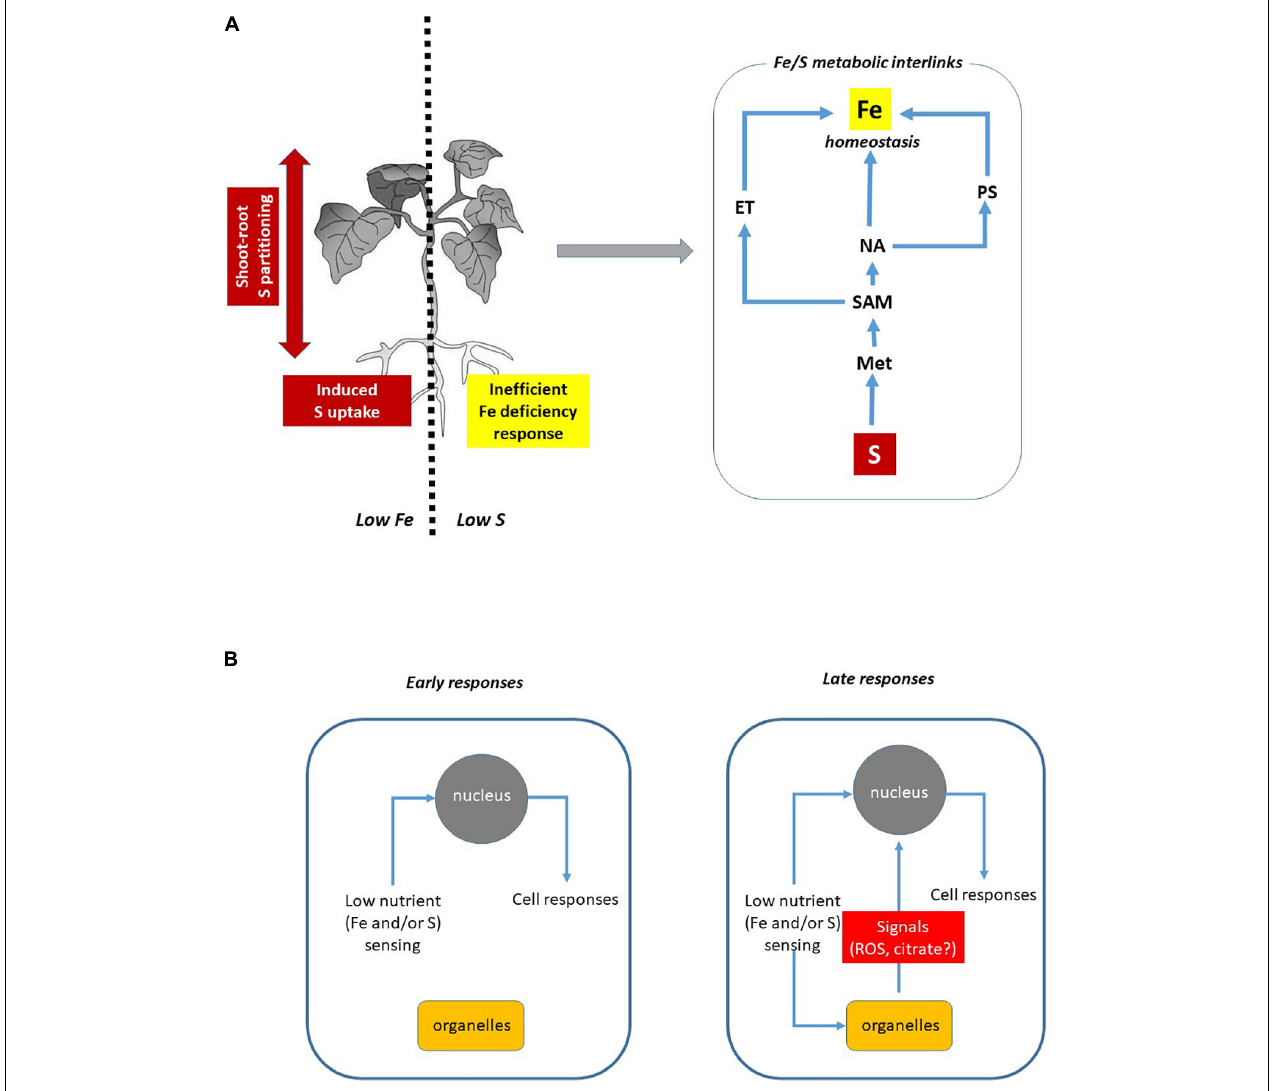
FIGURE 1 | Overview of Fe and S Interaction in plants. (A) In plants, Fe and S availability affect S and Fe homeostasis, respectively (left panel, see text for details). The metabolic interlinks between Fe and S seem to be related to the biosynthesis of specific compounds: S is essential for Met synthesis, the pivotal precursor of ET, NA, and PS through the SAM biosynthesis pathway (right panel). (B) Hypothetical involvement of organelles (such as mitochondria) in the modulation of Fe and S deficiency-induced responses. The engagement of specific cellular sensing and signaling pathways might depend on the progression/severity degree of nutrient deficiency. Mitochondria impairment might be a source of still unknown signals (likely ROS and/or citric acid) able to modulate cellular responses. ET, ethylene; Met, methionine; NA, nicotianamine; PS, phytosiderophore; SAM, S